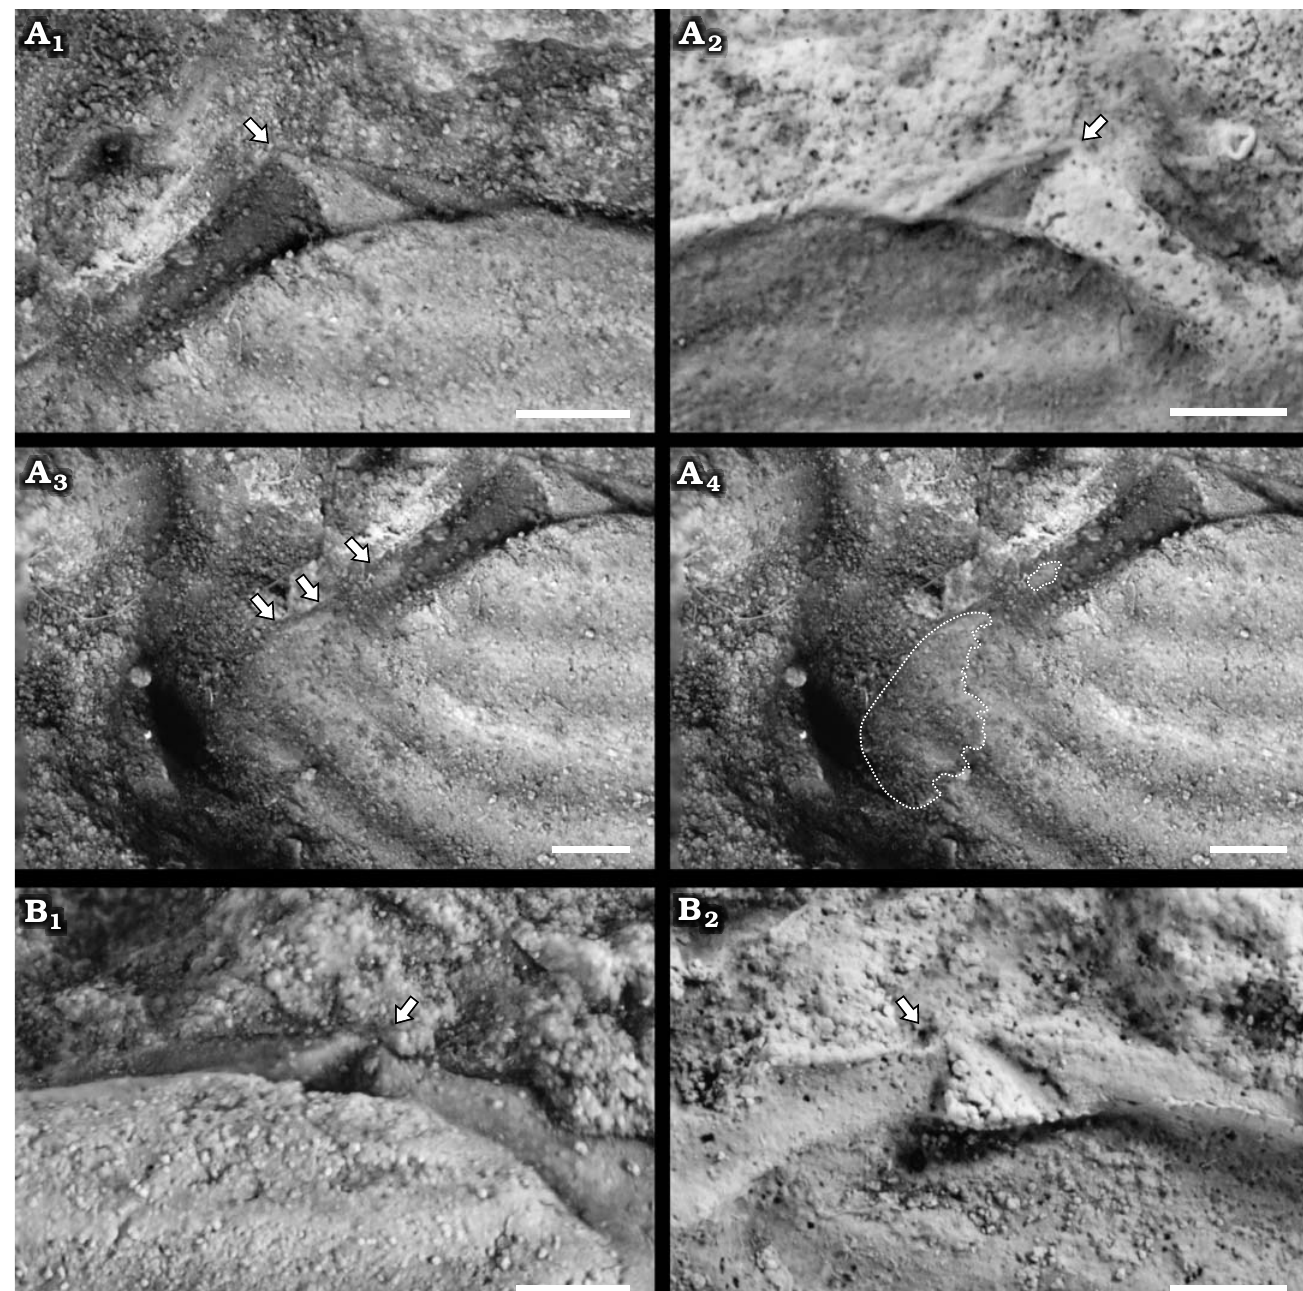
Fig. 4. Pachydomid bivalve Leinzia similis (Holdhaus, 1918) (sensu stricto), Rio do Rasto Formation, Guadalupian (Permian), Paraná Basin, Brazil. A . DGP/7-88, composite mold, left valve; A 1 , detail of the well-defined triangular socket (arrowed); A 2 , latex cast of specimen in A 1 , showing the hinge with well-defined triangular socket (arrowed); also note the absence of true lateral teeth; A 3 , details of the anterior adductor, pedal protractor, and pedal retractor muscle scars (arrows); A 4 , anterior muscle scars (outlined). B . DZP-20417, composite mold, right valve; B 1 , well-developed triangular, subcar- dinal, blunt tooth (arrowed); B 2 , latex cast showing the triangular socket (arrowed) and the hinge without true lateral teeth. Scale bars 1 shell margin (Fig. 3). Umbones low, prosogyrous; lunule Description .—Small (maximum observed length 36 mm), absent, escutcheon long, well-defined. Ligament probably thin-shelled, compressed bivalve, equivalve, posteriorly opisthodetic, parivincular, external. Hinge of right valve elongate (Figs. 3, 5B ), and with a well-defined rostrum 2 with large, anteriorly inclined triangular blunt tooth beneath (Fig. 5B). Dorsal and ventral margins are subparallel; pos- the umbo and a corresponding socket in left valve; true lat- terior margin sligthly concave (Figs. 3A , D, 5B ); cardi- 3 2 eral teeth absent (Fig. 4A , A , B). External valve ornamen- nal margin straight in front of beak. Posterior carina well 1 2 marked, running diagonally from beak to posterior-ventral tation with regularly spaced comarginal rugae extending to